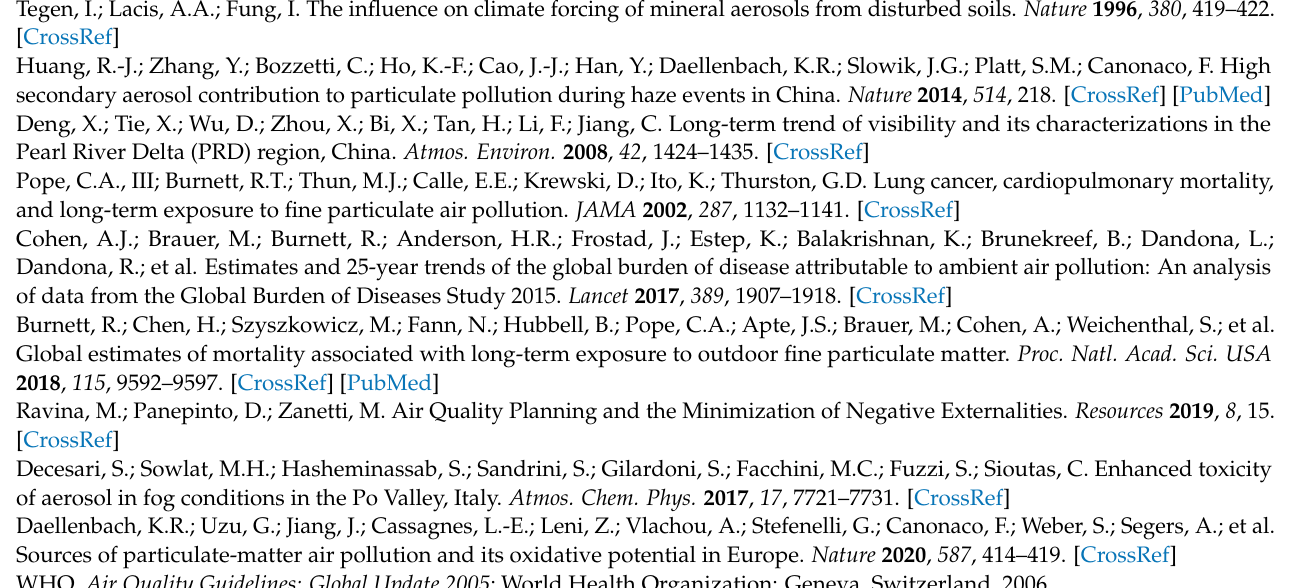
Figure S3: time series of f60 ; Figure S4: Diurnal patterns of the meteorological parameters; Figure S5: diurnal pattern for the OA factors during weekdays and weekends; Figure S6: diurnal pattern of BC during weekdays and weekends; Figure S7: Mass spectral profile comparison; Figure S8: Distribution of the scaled residuals; Figure S9: time series of f44 / f43 ; Figure S10: wind rose; Figure S11: Polar plot of BC; Figure S12: Polar plot of OOA factors. Table S1: Criterion list for both seasonal and rolling PMF; Table S2: Comparison of the correlation r 2 for the MO-OOA and